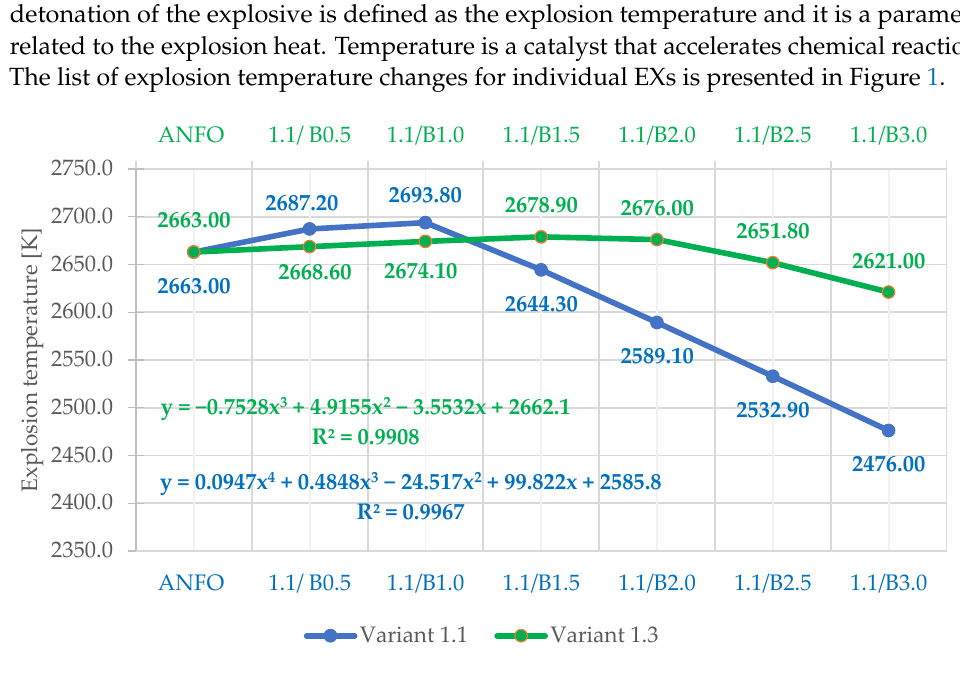
y = equation of the trendline function R 2 — the coefficient of the quality of the model fit Figure 1. Explosion temperature changes for individual explosives. Figure 1. Explosion temperature changes for individual